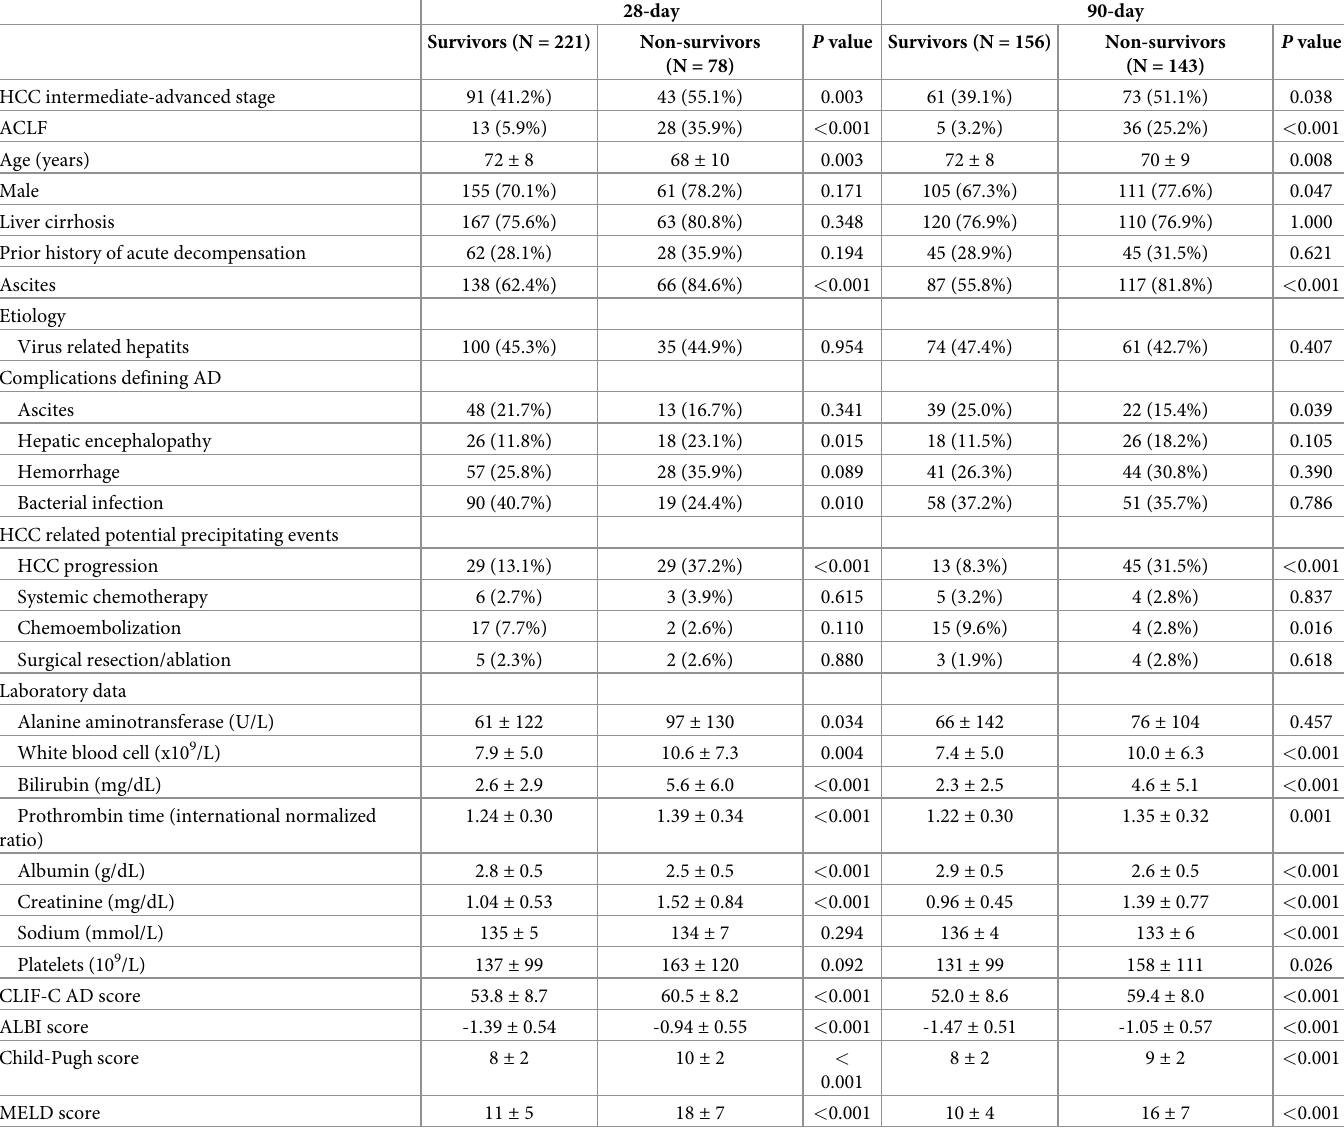
Table 10. Patient characteristics stratified by survivors or non-survivors at day 28 and day 90 in cases with acute